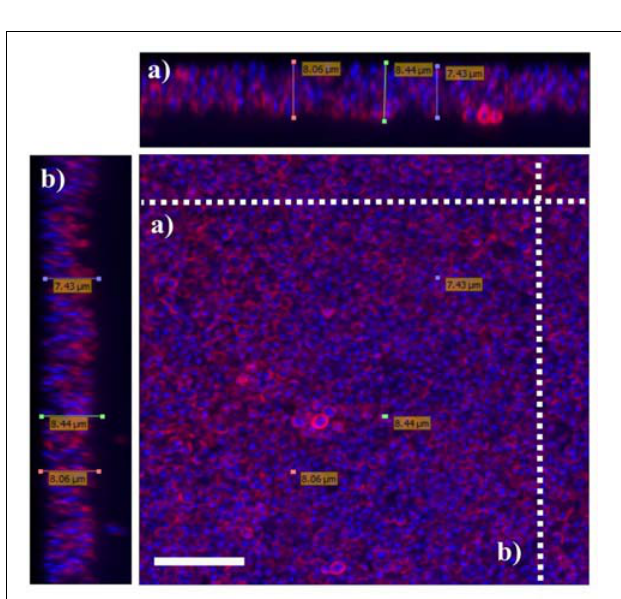
as indicated by highest OD upon staining with crystal violet.